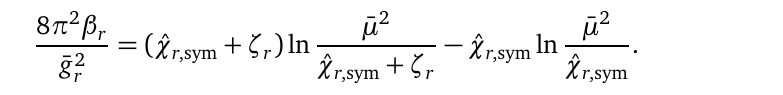
Figure 2: The phase diagram of the theory in terms of the parameters β ζ (in units of ¯ µ 2 ). The orange line separates the phase of broken symmetry (white r region), where there is no generation of a gluon mass at tree level, from that of restored symmetry (shaded resion), with ˆ N α = 0, where a nonzero gluon mass is generated at tree level. The transition between the two phases is continuous. In the massive phase, the renormalized tree-level square gluon mass is β < 0 is thus excluded in a perturbative region with β r